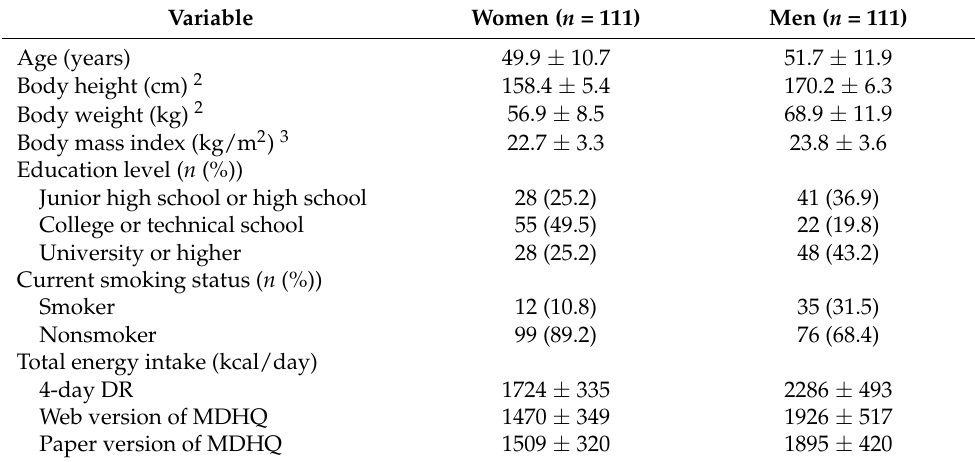
Table 1. Basic characteristics of the study population 1